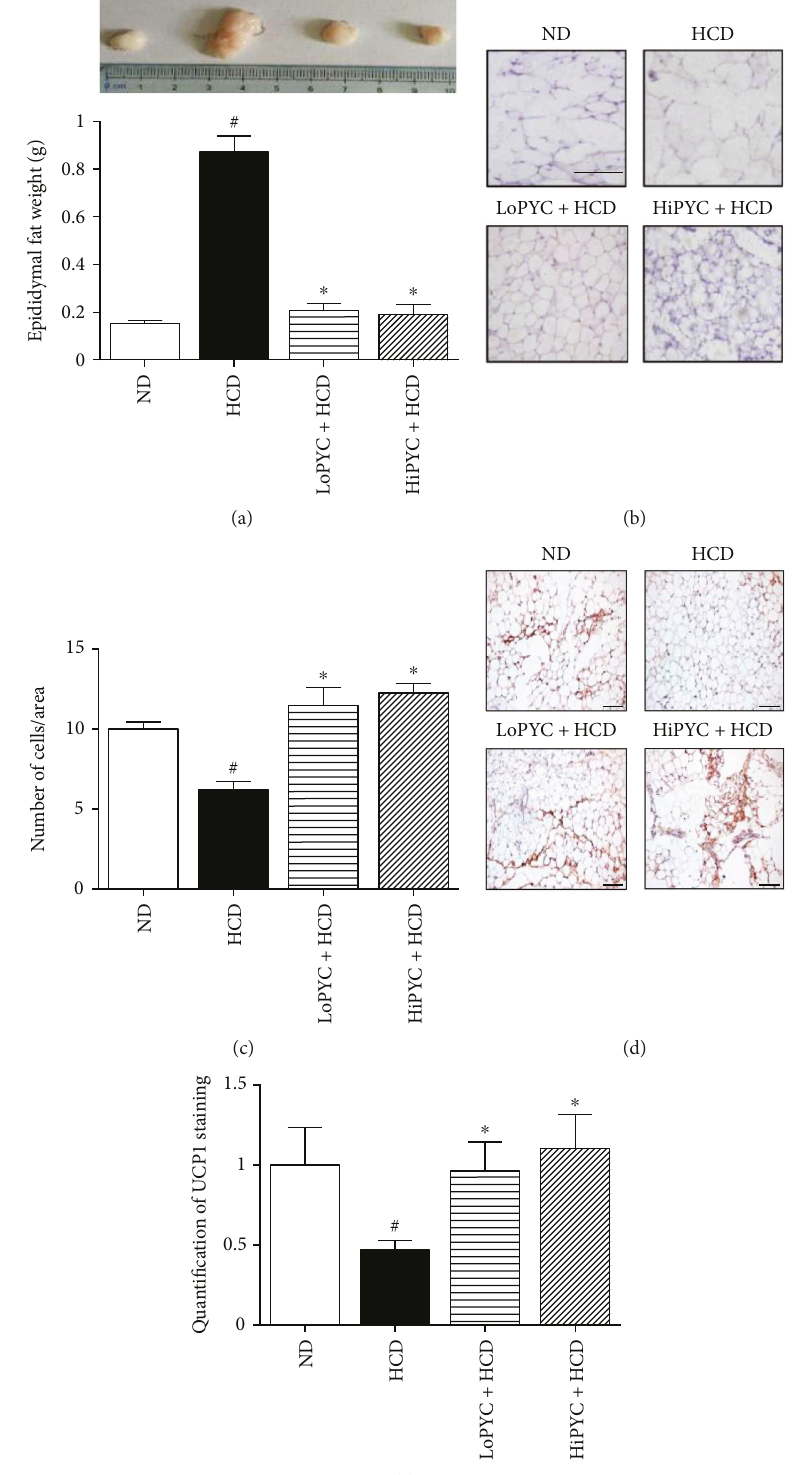
Figure 2: PYC decreased the eWAT mass and the size of adipocytes within eWAT. (a) The eWAT mass; (b) H&E staining of eWAT to observe the size of adipocytes, scale bar =50 μ m; and (c) the number of cells/area in H&E-stained sections. (d) UCP1 staining in eWAT. Pictures are shown at 20x magni fi cation; scale bar =100 μ m. (e) Quanti fi cation of UCP1 staining in eWAT. The data are expressed as the means ± SE for 5 mice per group. # p < 0 05 versus the ND group; ∗ p < 0 05 versus the HCD